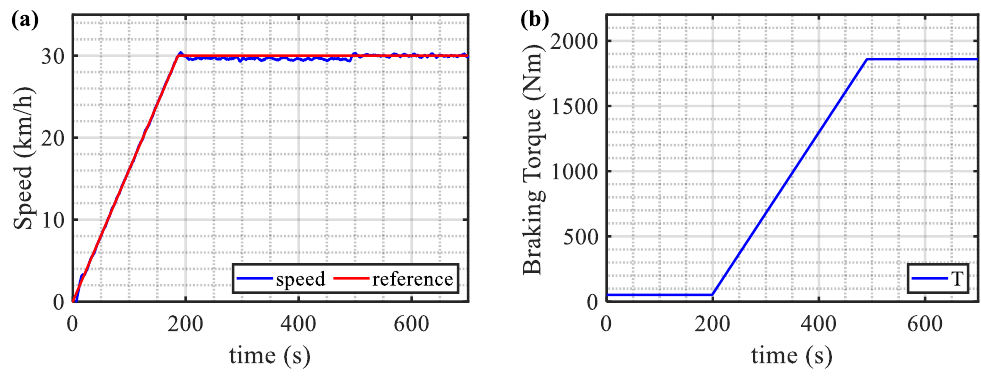
Figure 20. Test conditions and results: ( a ) Vehicle speed tracking; ( b ) Brake torque trajectory.